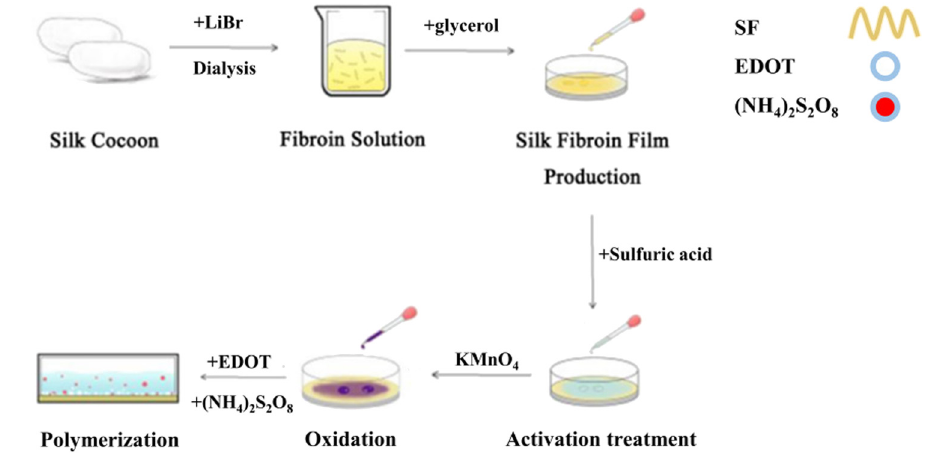
Figure 2: Flow chart for preparation of SF/PEDOT fi